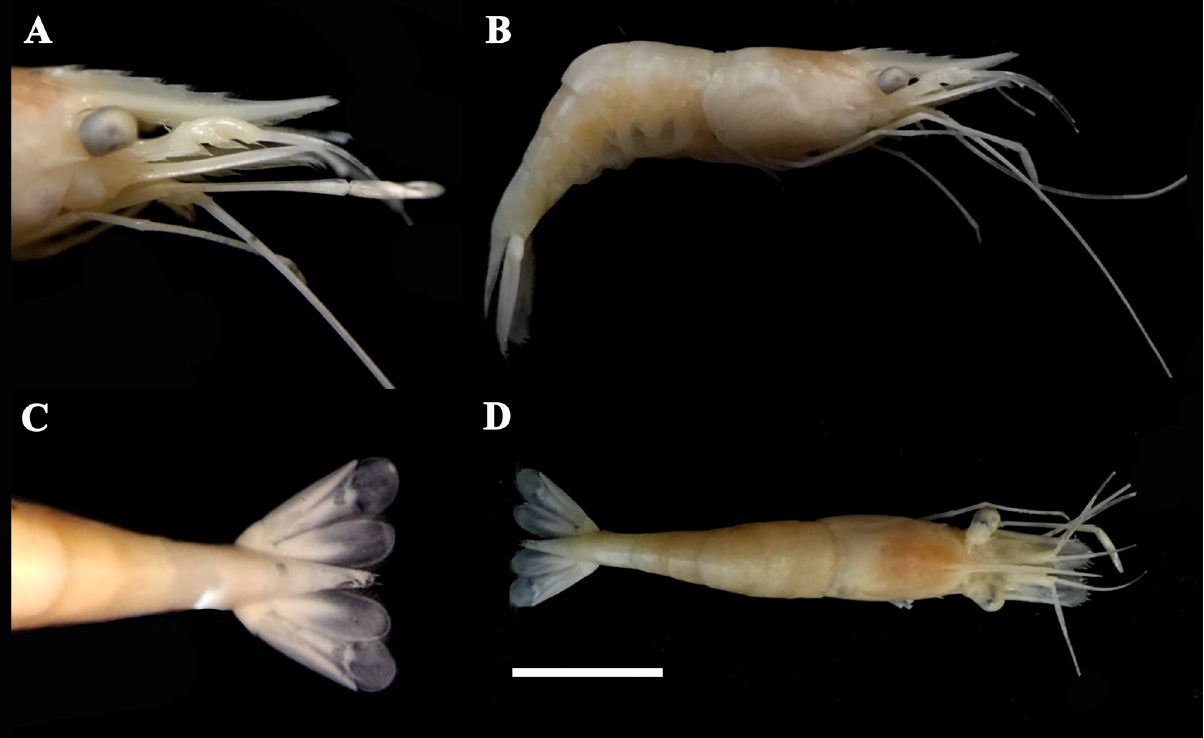
Figure 5. Macrobrachium jelskii (Miers, 1778), female (LSZ 027). A, Detail of the anterior region of the carapace; B, habitus, lateral view; C, detail of the telson and uropods, dorsal view; D, habitus, dorsal view. Scale bar: 1